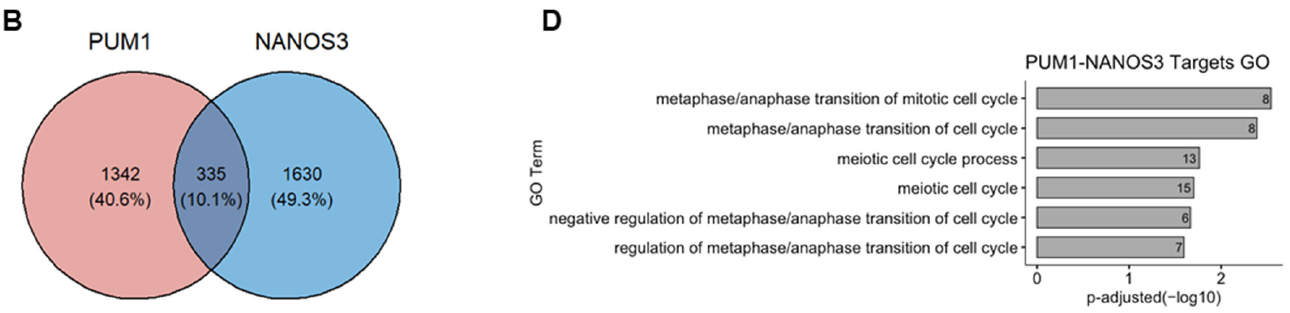
Figure 4. FOXM1 and TAF1 act as transcription factors for NANOS1 and NANOS3 downregulated genes. ( A ) Cumulative distribution analysis of differentially expressed genes upon NANOS3 RNA- Seq. Common differentially expressed mRNA distribution shown in blue and labeled as targets. The rest of the differentially expressed genes are shown in red and labeled as non-targets. ( B ) Common differentially expressed genes that are repressed by both NANOS3 and PUM1 identified as down- regulated (log2FC < 0) upon NANOS3 overexpression and upregulated (log2FC > 0) upon PUM1 knockdown. ( C ) iRegulon transcription factor prediction analysis for NANOS3/PUM1 common repressed genes. ( D ) Cell cycle related biological processes identified by gene ontology enrichment analysis for NANOS3-PUM1 common repressed genes.